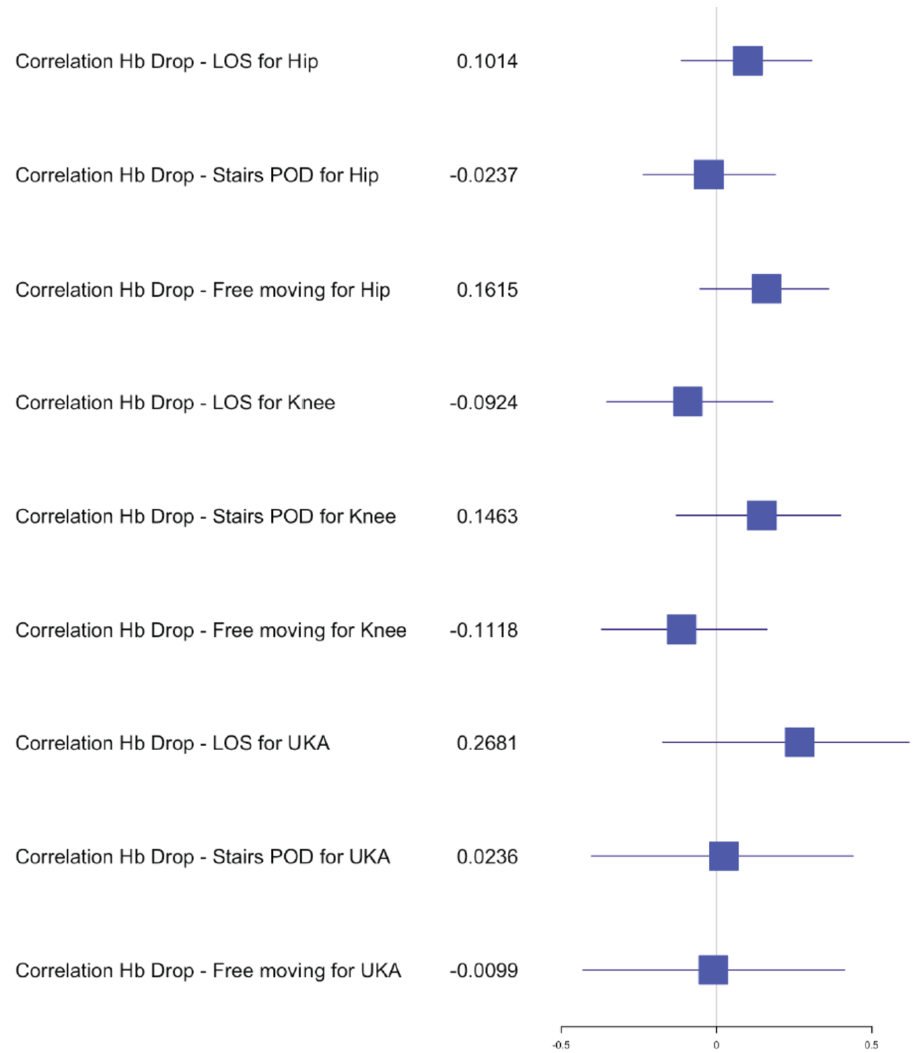
Figure 4. Forest plot for the effects of Hb drop on LOS and functional outcome for simultaneous arthroplasty.